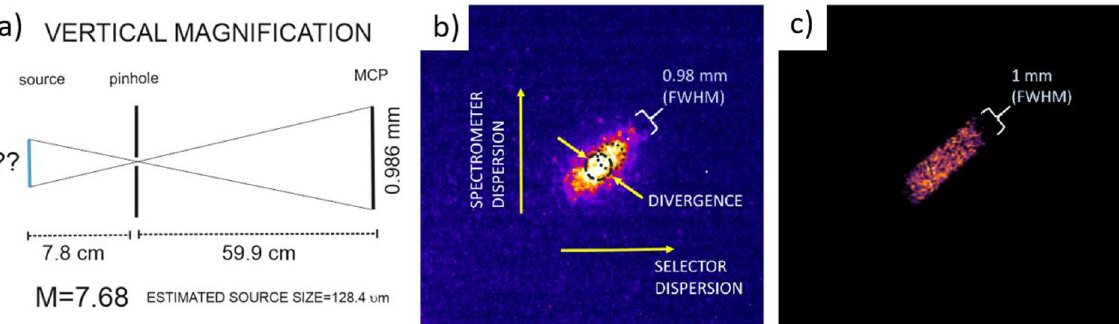
Figure 4. ( a ) Sketch of the point like pinhole magnification system. ( b ) Typical proton signal on MCP obtained with configuration of 20 µ m slit and 20 µ m pinhole that corresponds to 44 keV energy bandwidth (FWHM) and proton trace width of 0.98 mm. ( c ) Proton signal on MCP obtained with FLUKA simulation reproducing an ∼ experimental result of energy bandwidth of 44 keV (FWHM) and width of 150 µ m.